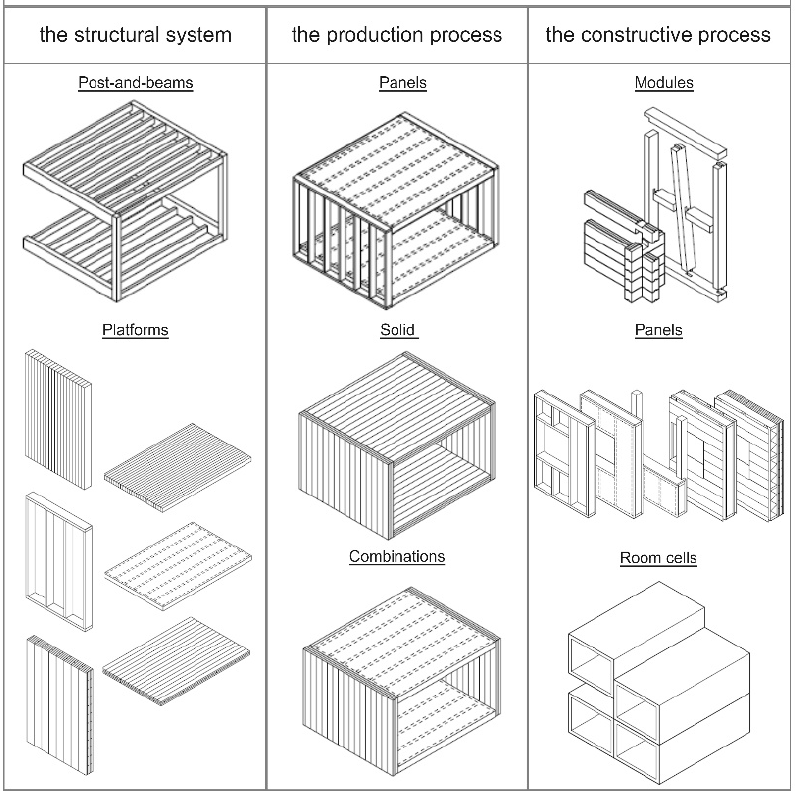
Figure 2. Three main categories for the classification of multi-storey timber buildings according to [38,41,43].